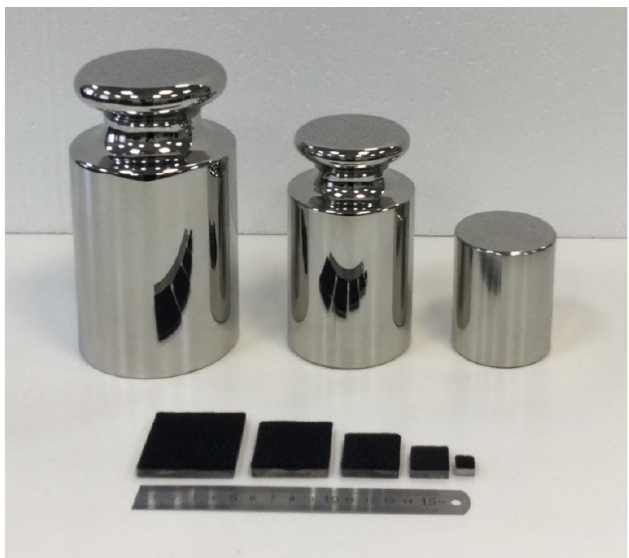
Figure 2. Dead weights (10, 5 and 2 kg, respectively) and pads used in calibration.